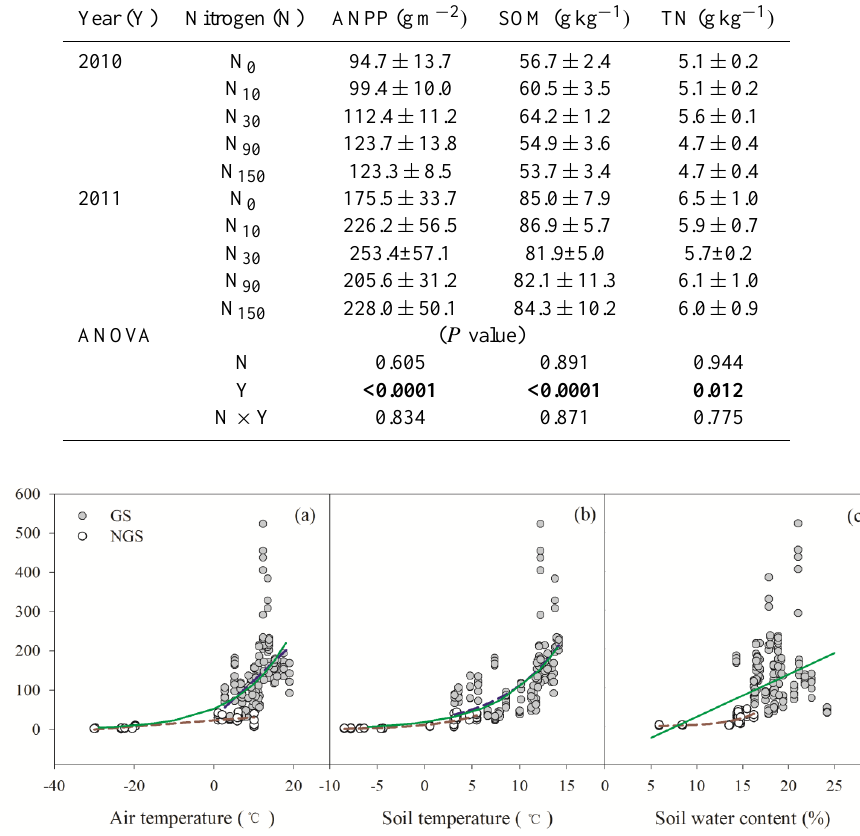
fluxes ( R ) and air temperature (a), soil 870 2 e